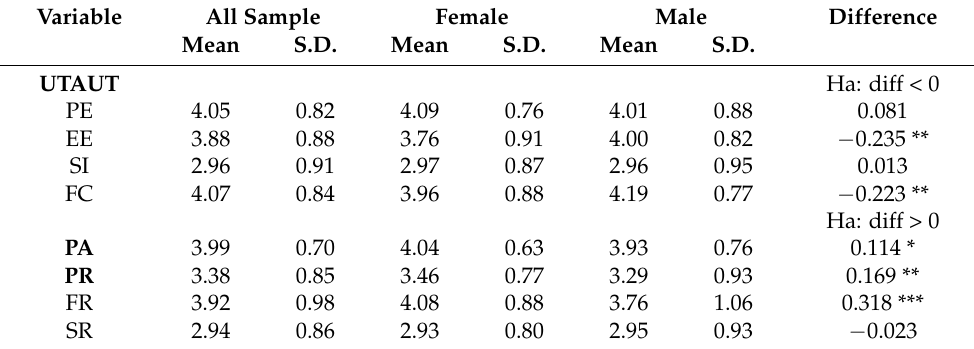
Table 2. Descriptive statistics of each construct, by gender.